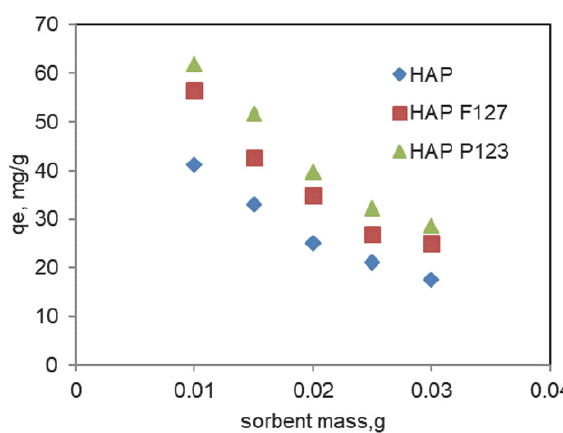
Figure 1. Nitrogen sorption isotherm and corresponding pore size distributions for the synthesized HAP samples. Figure 2. Dependence of adsorption process on the sorbent